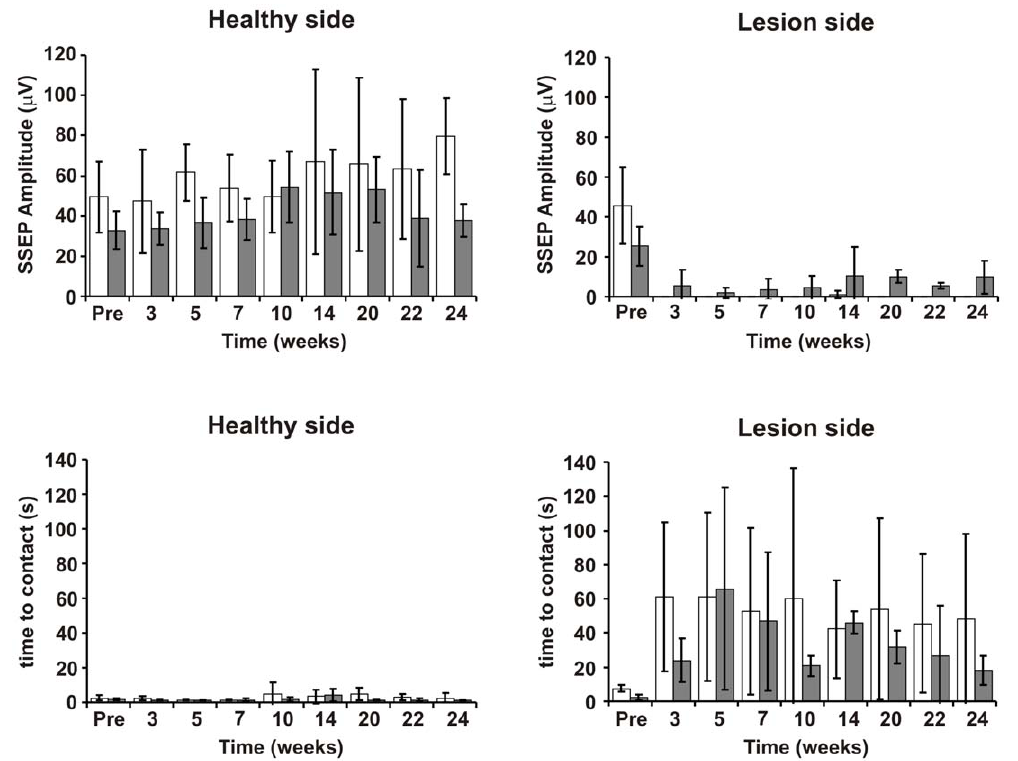
Figure 7. Quantitative analysis of electrophysiologic data during recovery. Top row , Amplitude (in m V) of the somatosensory evoked potentials detected over the S1 FL cortical area of the brain, acquired during the fMRI sessions. Bottom row , result of the sticky tape behavioral test. Time to contact the tape stuck to the forepaws of the animals is presented (mean 6 standard deviation, in seconds). As in Fig. 4, the plots present the data for the control group (white bars), and for the group of animals treated with stem cells that recovered BOLD signal (dark gray